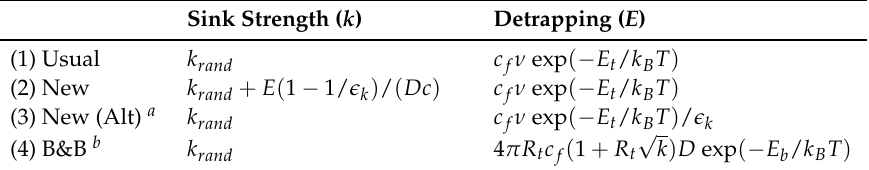
Table 1. The sink strengths and detrapping terms used for the RE test simulations. k rand is given by Equation (3).